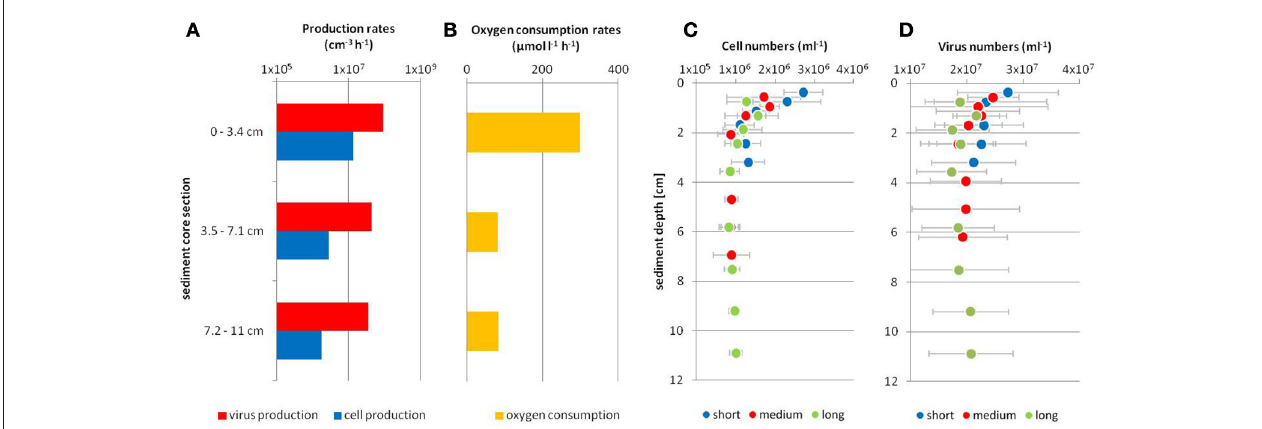
FIGURE 5 | Gross virus and cell production rates, oxygen consumption rates, virus, and cell numbers in the effluents during tidal simulation experiments of the February experiment. Virus and cell production rates as well as oxygen consumption rates (A,B) for different column sections in the reactors were derived by the following calculations: section 0–3.4cm values of the short column, section 3.5–7.1cm subtraction of values from the short column from the medium column and section 7.2–11cm subtraction of the values of the medium column from the long column during continuous water flow and the proportion of free viruses and cells in the sediments. Virus and cell numbers (C,D) represent numbers of the different sediment columns released in the effluents after 6h of low tide (average of four tidal cycles, see Figure 3 ). Numbers are plotted at the respective column depth where the sampled water had been incubating during low tide by calculations including the porewater volume and the retention time of the